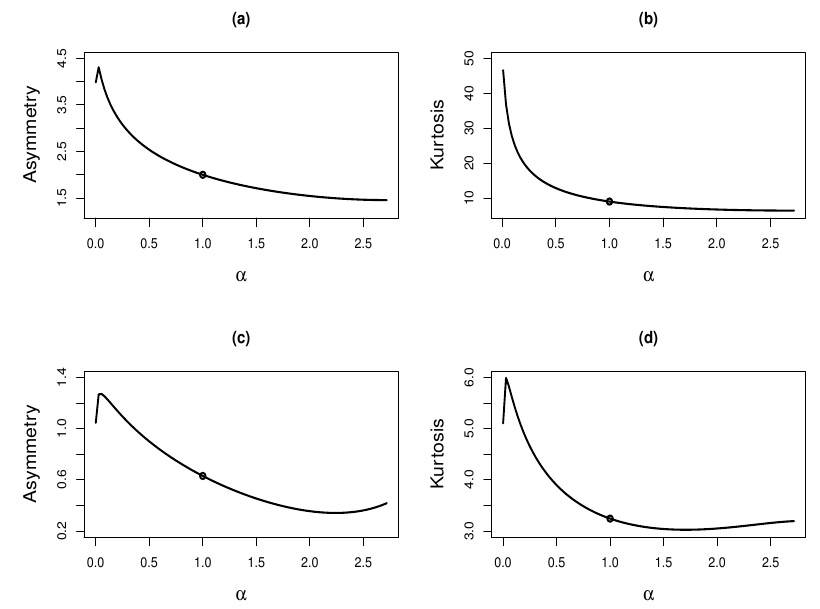
Figure 3. Plots of the asymmetry and kurtosis coefficients for the Lambert-exponential (solid line) and exponential (circle) distributions (panels ( a , b )) and for the Lambert–Rayleigh (solid line) and Rayleigh (circle) distributions (panels ( c , d